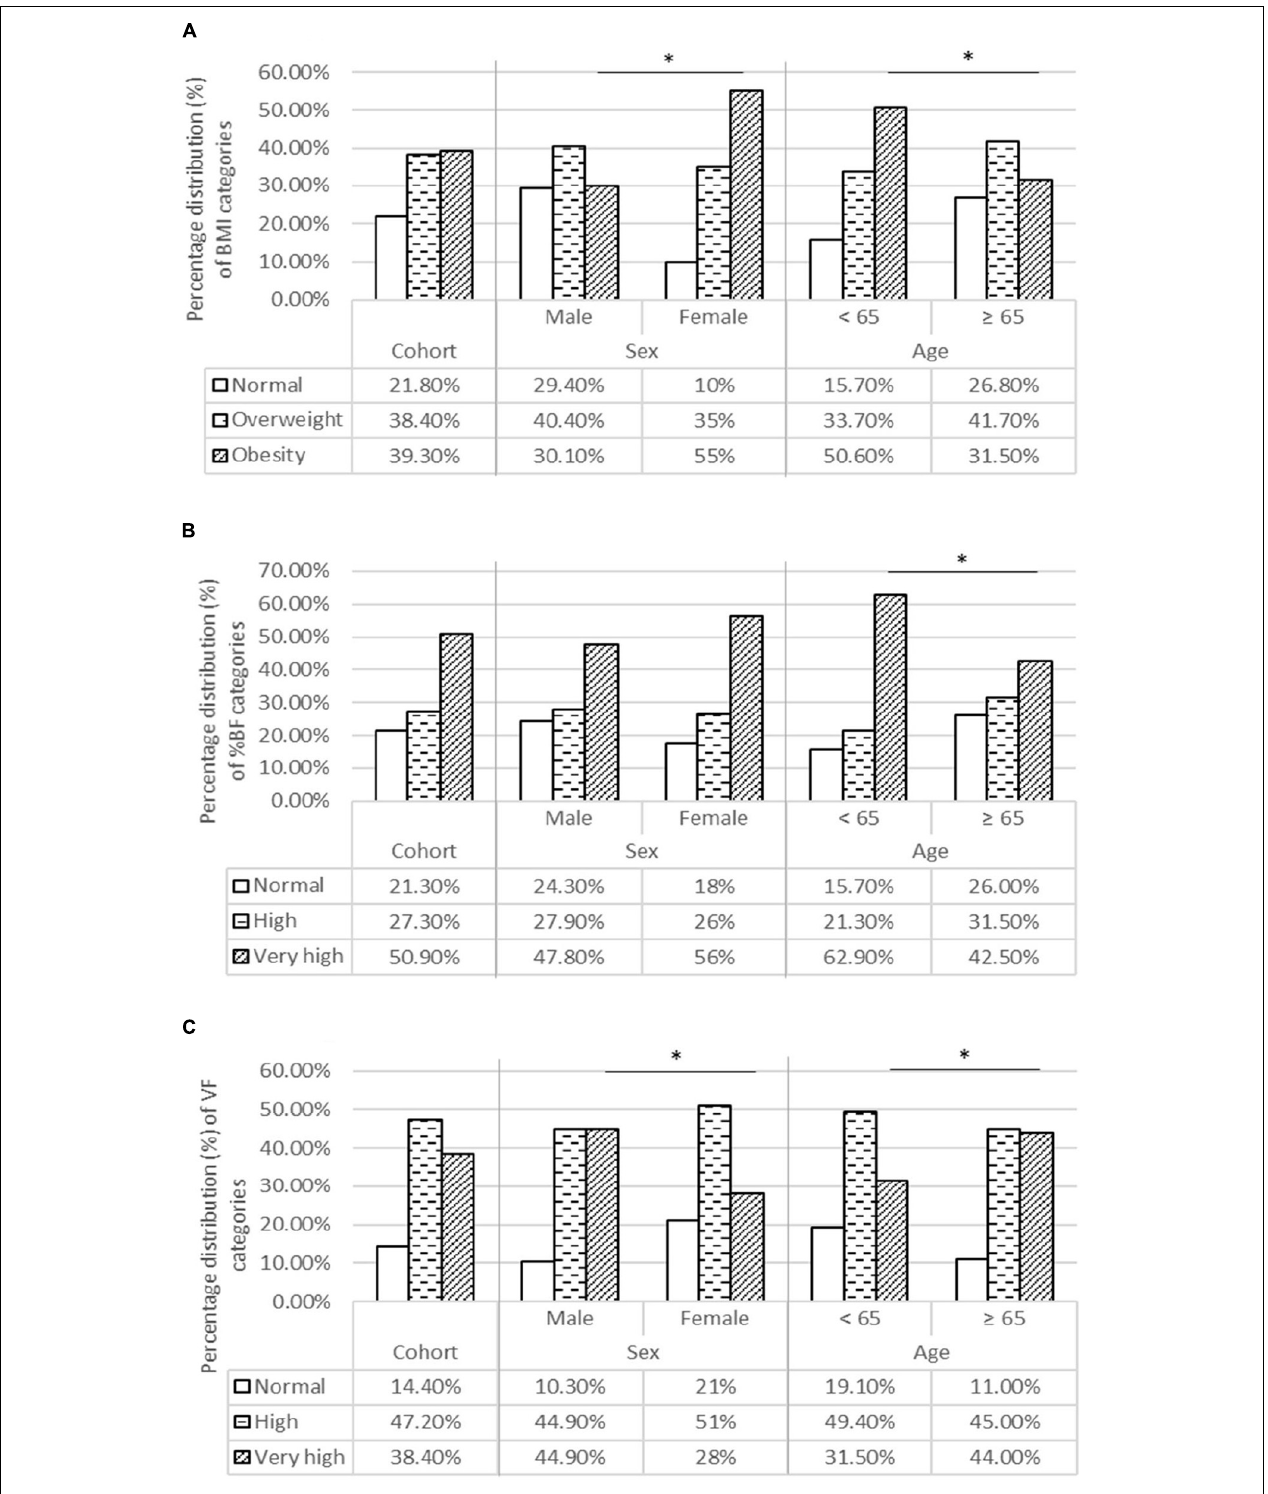
FIGURE 1 | Body composition categories for BMI (A) , BF% (B) , and VF (C) in the entire cohort and for age and sex categories. (A) Percentage distribution of BMI categories. (B) Percentage distribution of % BF categories. (C) Percentage distribution of VF categories. BF %, Body fat percentage; BMI, Body mass index; VF, Visceral fat. ∗ Statistical significance level is taken for “ p ” values below 0,05, using the χ 2 -test.